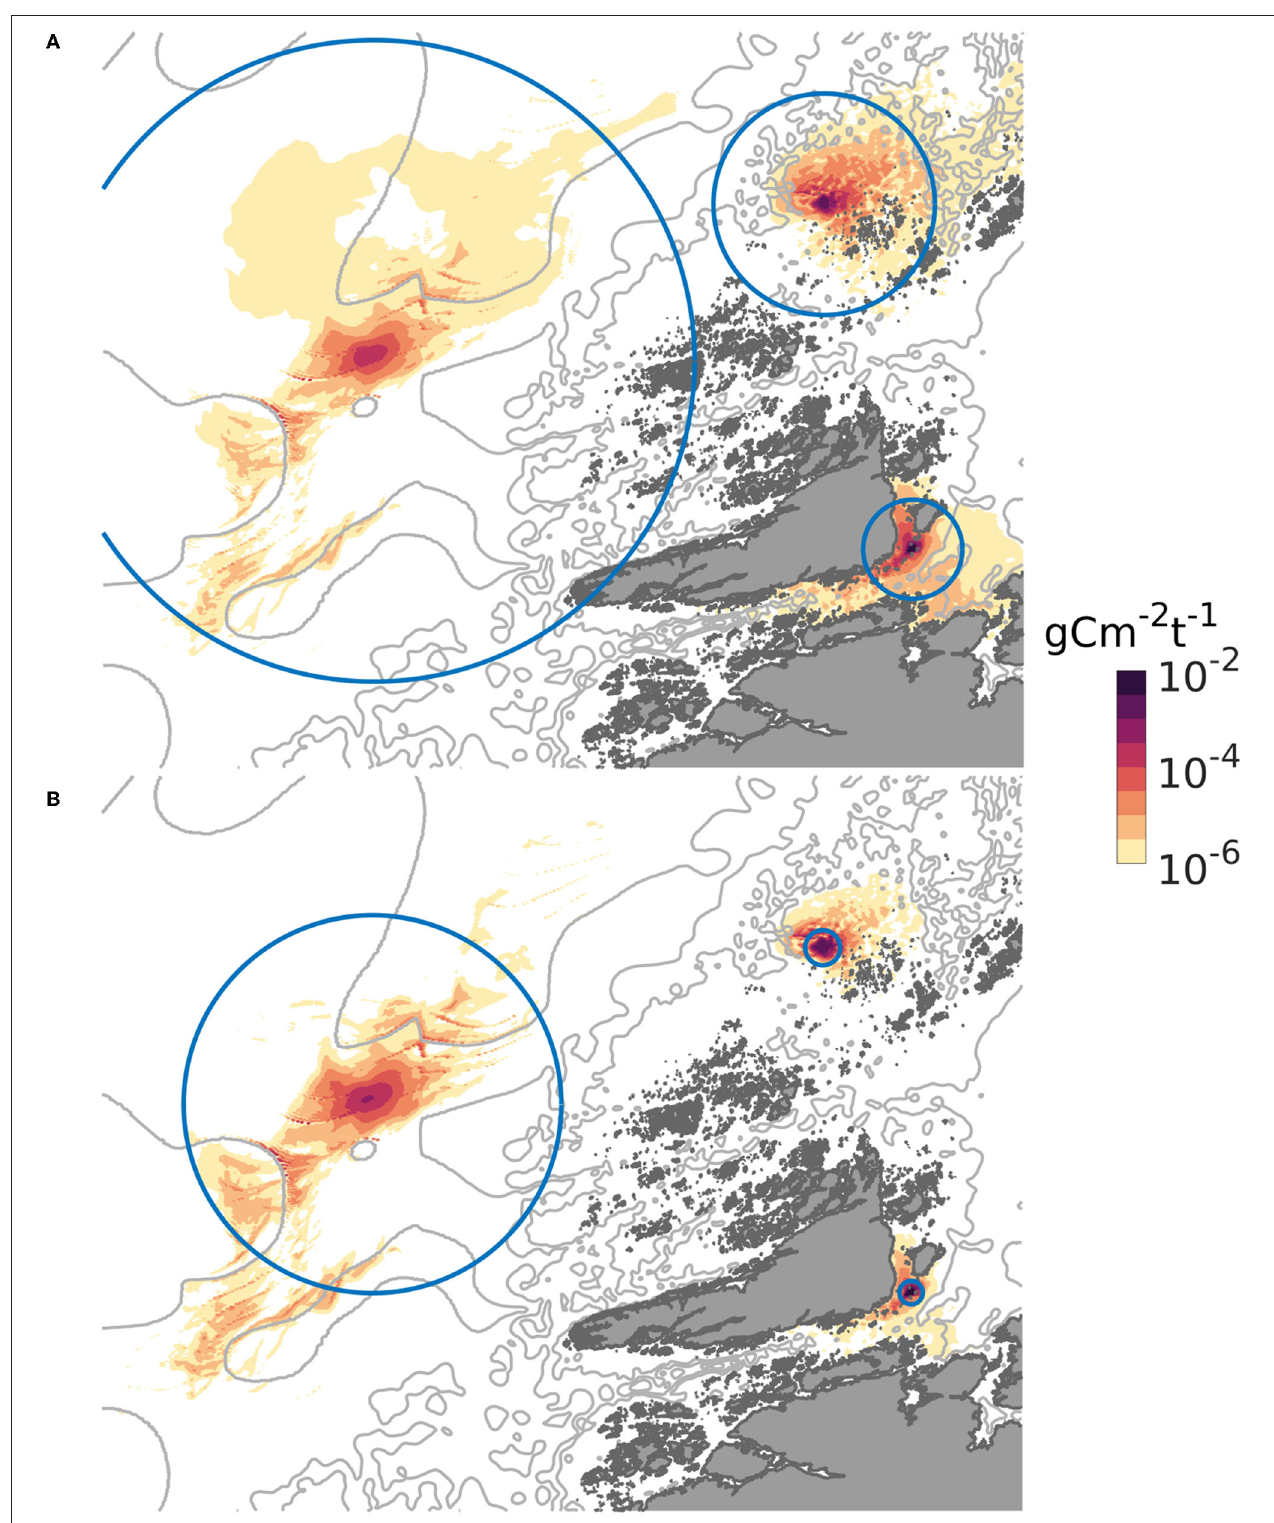
FIGURE 3 | Spatial distribution of POM from the three locations on the sea floor, expressed as g C m − 2 (t WW harvested biomass) − 1 , June. The gray curves are 100, 200, and 300 m isobaths. The circles indicate the region within which 90 per cent of the released POM deposited. In (A) , representing scenario A, the radii of the circles were 4, 10, and 28 km, for the sheltered, exposed, and offshore scenarios, respectively. In (B) , representing scenario B, the radii of the circles were 1, 1.5, and 16 km for the sheltered, exposed, and offshore scenarios, respectively. The colormap used is described in Thyng et al. (2016).